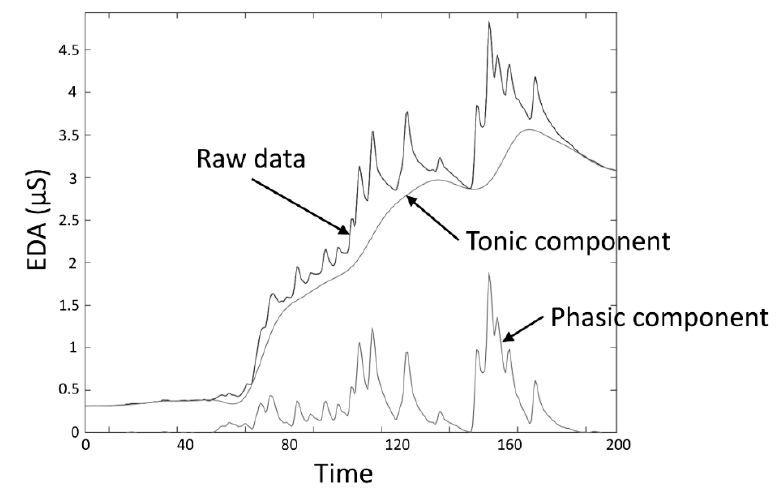
Figure 3. EDA data decomposition into tonic and phasic components.